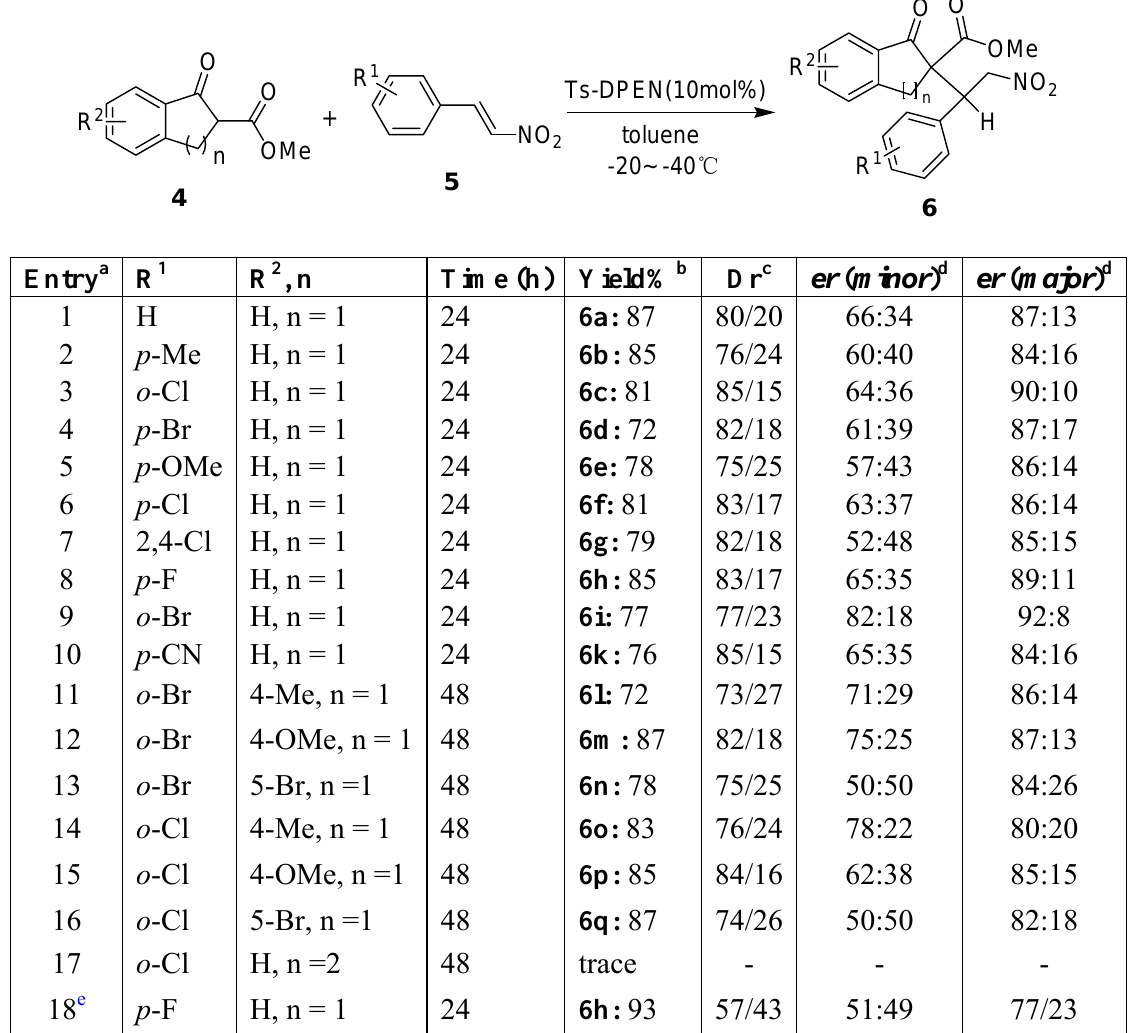
Table 1. Enantio- and Diastereoselective Michael Reactions of Nitrostyrenes in the presence of catalytic